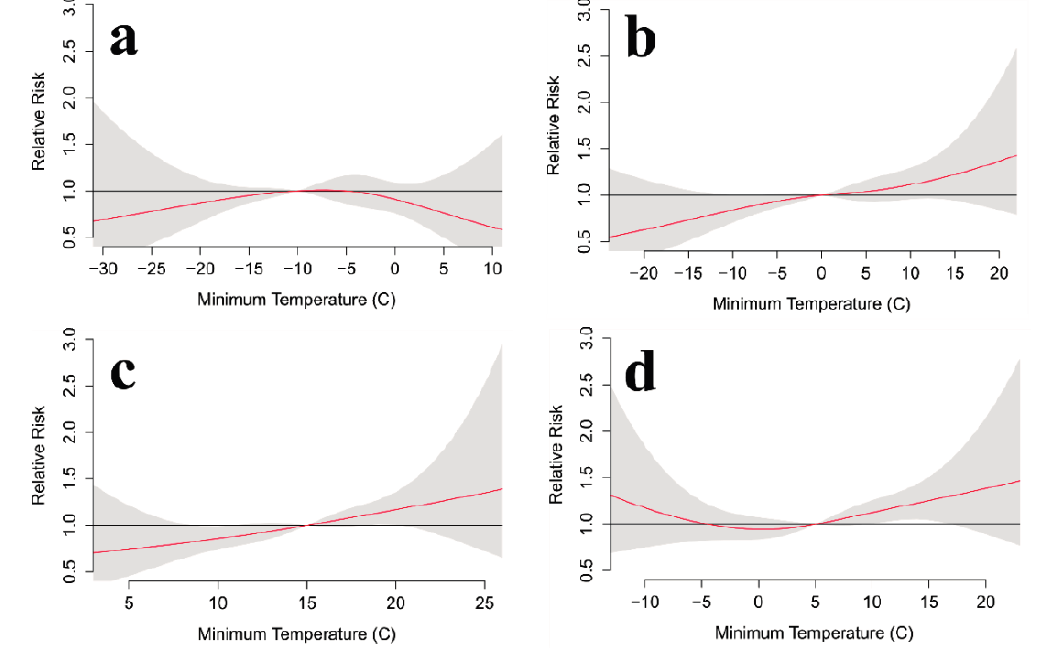
Figure 10. Toronto relative risk for suicide at various daily minimum temperatures over a 6-day lag for ( a ) winter, ( b ) spring, ( c ) summer, and ( d ) fall. The red line is the predicted value and the gray shading represents the 95% confidence